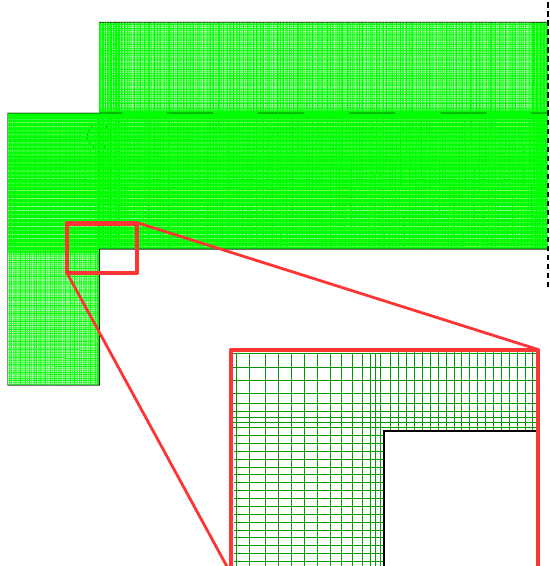
Figure 3. Structured mesh containing 120,000